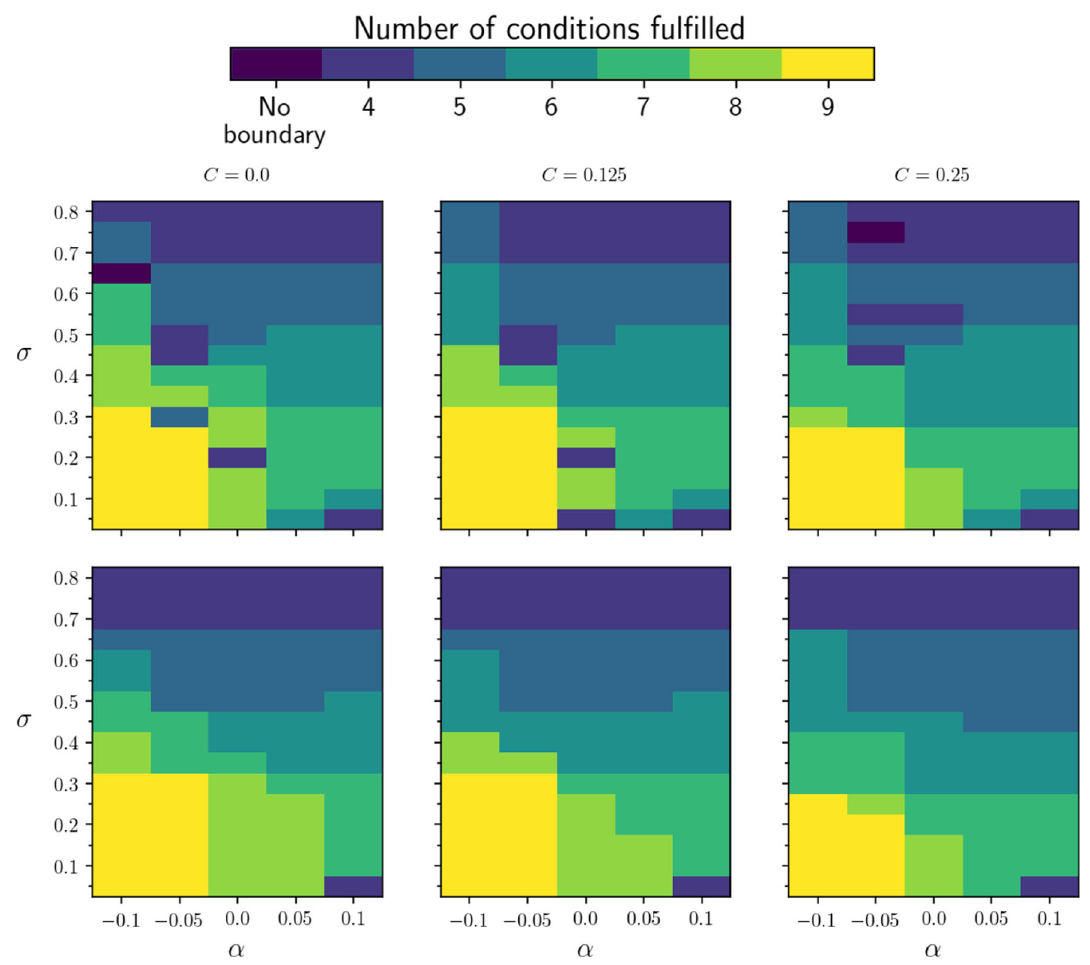
Fig. 8 Parametric space for the Lane–Emden master equation, for models with polytropic index n = 1 . 0 and parameters α , σ and C vary- ing from − 0 . 1 to 0 . 1, 0 . 05 to 0 . 8 and 0 . 0 to 0 . 25, respectively. When (cid:18) = 0 . 05 (top plates) the parameter space does not differ much from